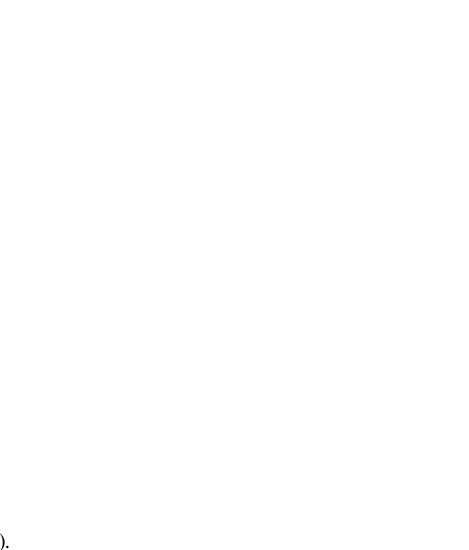
Table 1. Solutions of physical parameters via − f ′′ ( 0 )